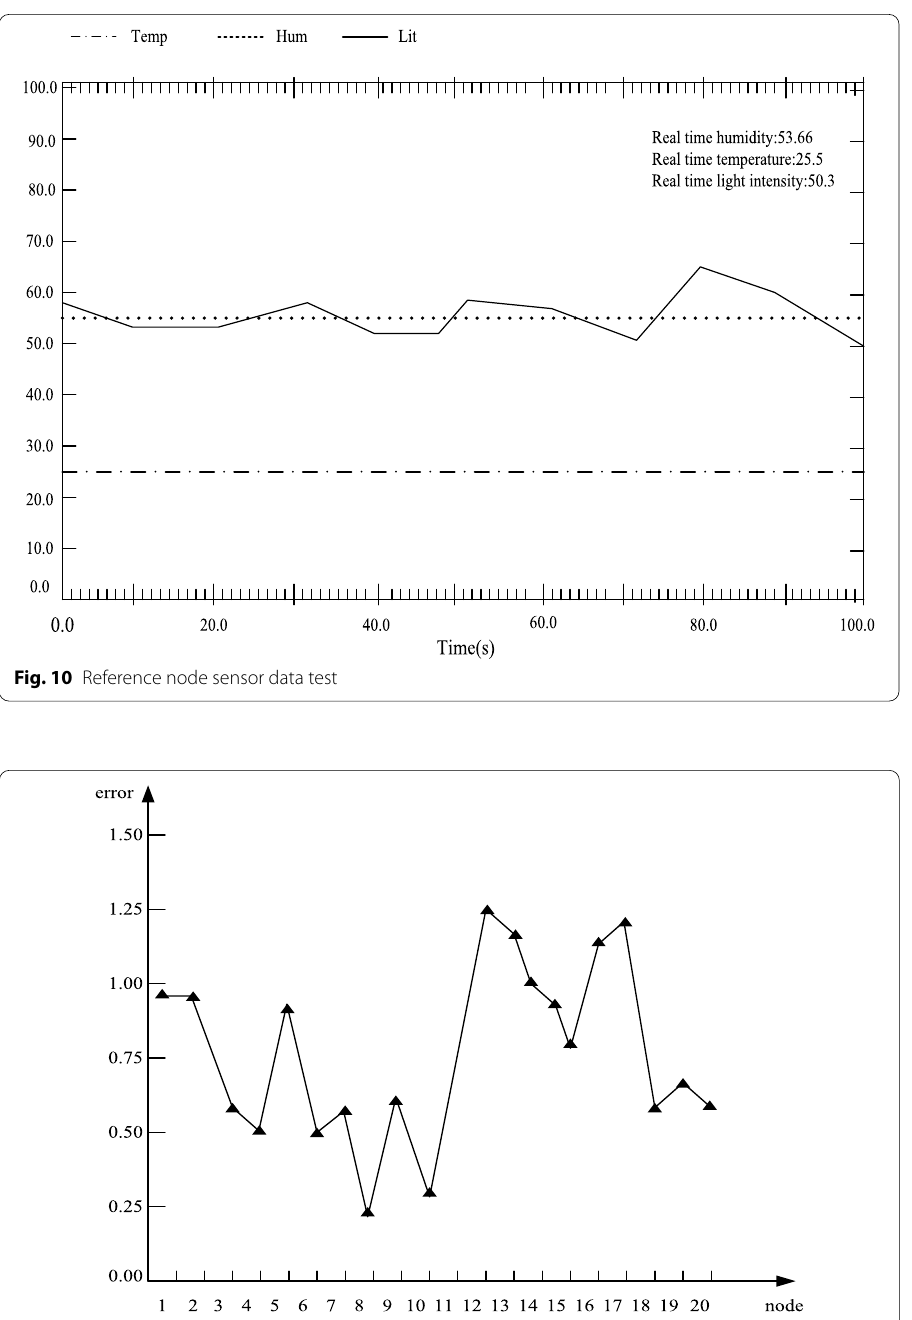
Fig. 11 Mobile node localization test results